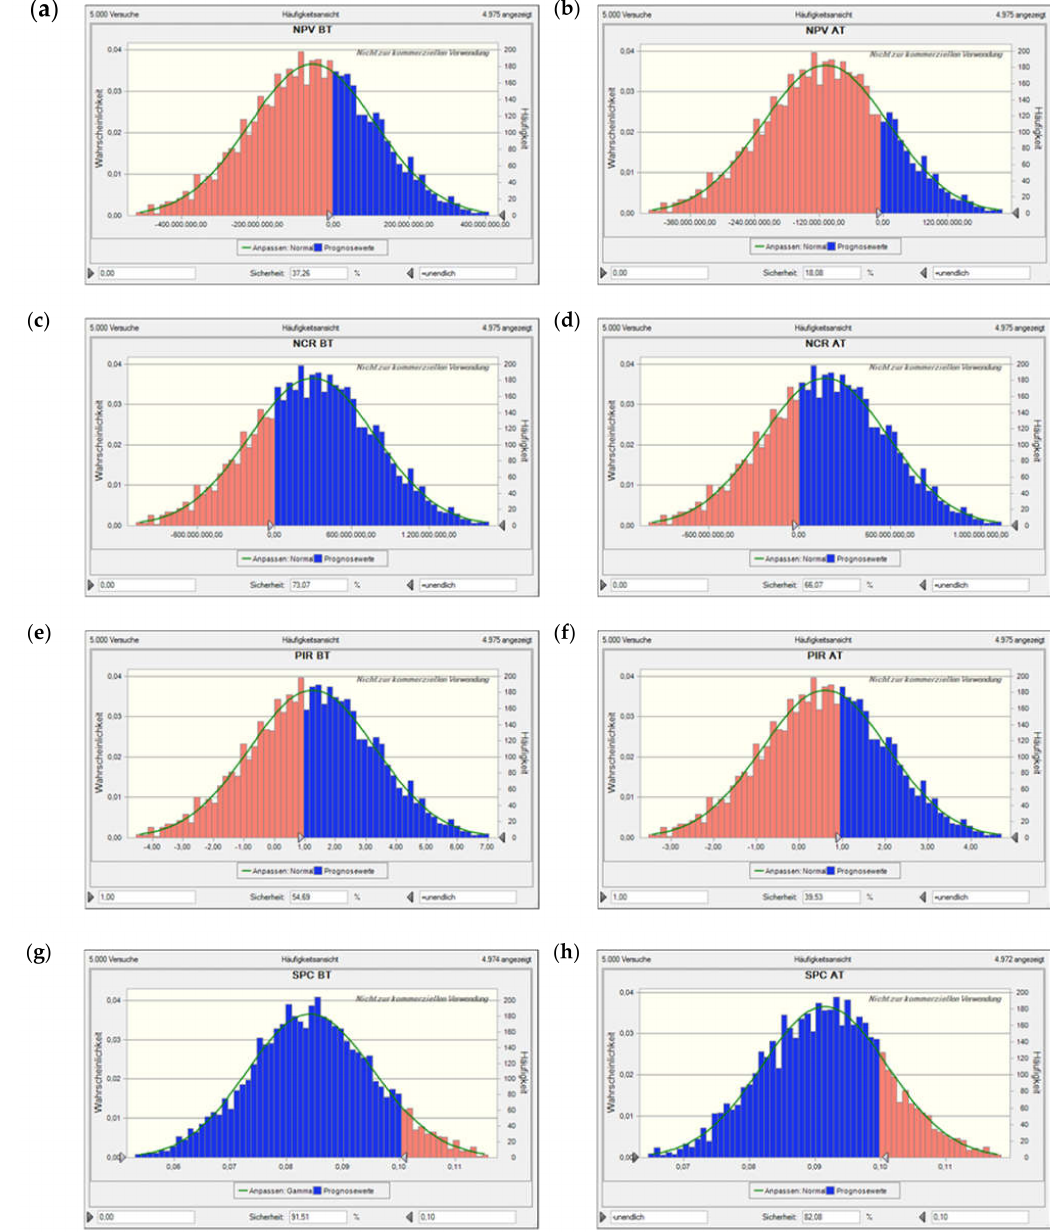
Figure A3. Value at risk for Scen. 1, excl. flooding time, based on a monte Carlo simulation with 5000 runs. Plots ( a ) and ( b ) show the net present value (NPV) before and after tax, plots ( c ) and ( d ) the NCR before and after tax, plots ( e ) and ( f ) the profit-to-investment ratio (PIR) before and after tax, and plots ( g ) and ( h ) the per unit (specific) production costs (SPC) before and after tax. The solid lines denote the fitted probability distribution, the red areas the confidence interval of not encountering a neg. NPV, neg. NCR, or PIR < 1 (i.e., depending on the performance indicator concerned; as the costs considered are all positive, there is only a blue histogram in those two